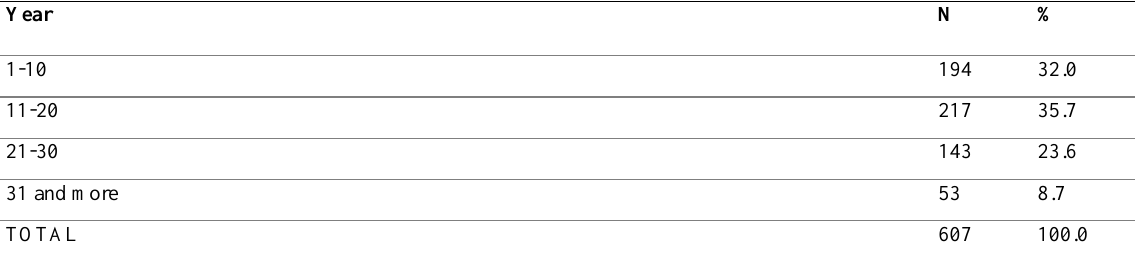
Table 5: Time of Service as a Doctor